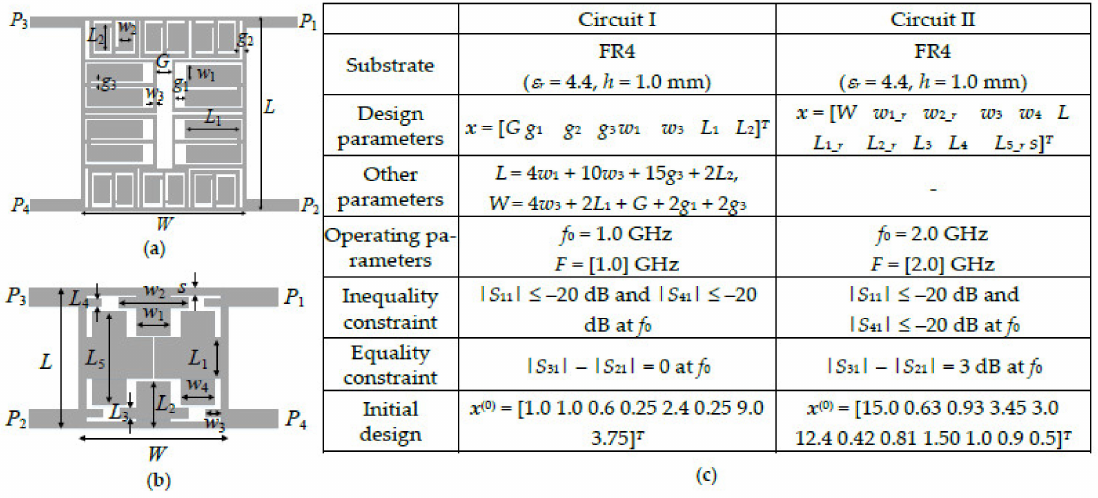
Figure 18. Demonstration case studies for equality constraint correction methodology of [45]: ( a ) branch-line coupler geometry (Circuit I) [59], ( b ) branch-line coupler geometry (Circuit II) [60], ( c ) essential circuit